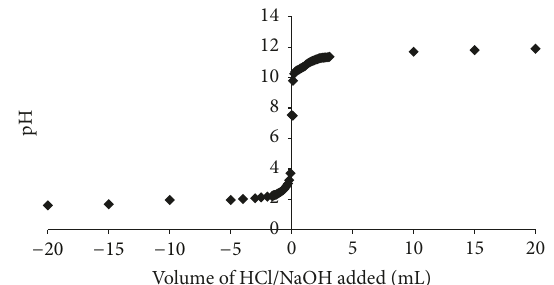
Figure 6: Titration curve of the zirconium-based ferromagnetic